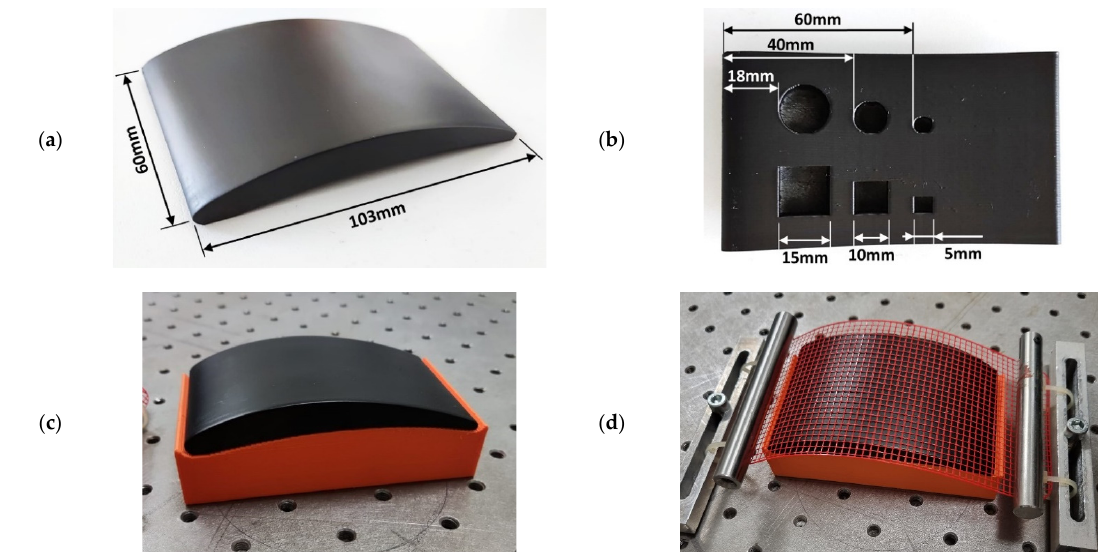
Figure 6. ( a ) Picture of the sample with the indication of footprint dimensions; ( b ) picture of the back wall with the indication of FBH locations and sizes; ( c ) sample placed on the supporting base without grid; ( d ) sample with the grid.